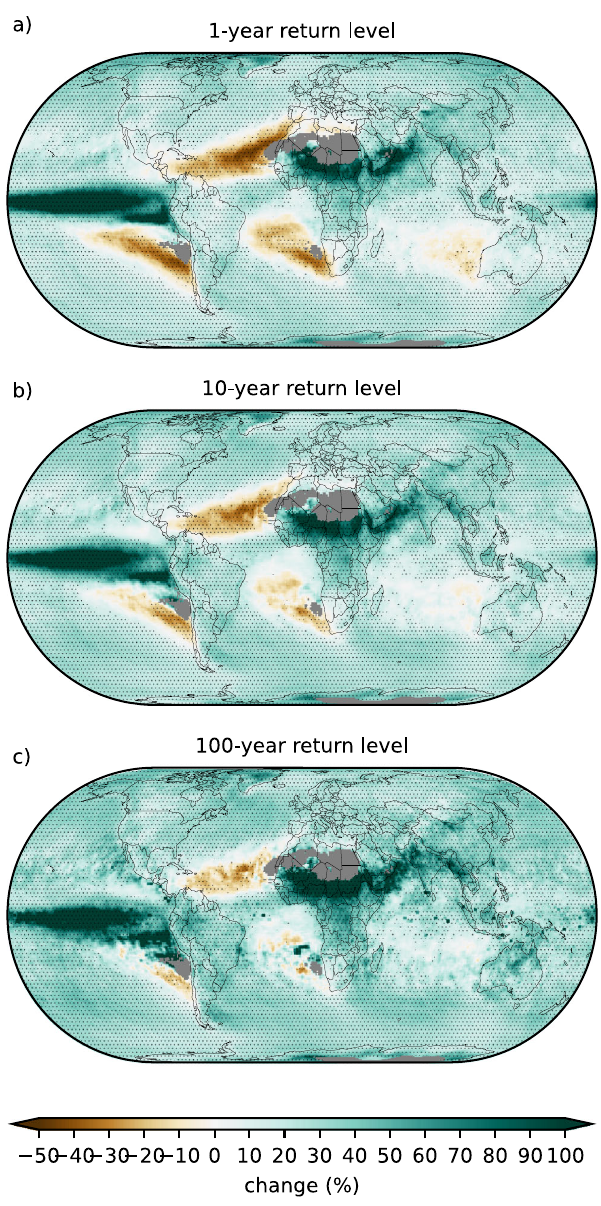
Fig. 2 Relative change of future vs historical precipitation return levels. Relative change of the a 1, b 10 and c 100-year return levels of daily precipitation expressed as weighted mean across 25 CMIP6 models for the SSP5-8.5 future period (2071-2100) with respect to the historical period (1971 – 2000) (Eq. (2)). Hatching is in the locations where >75% of the weighted models agree on the sign of the change. Dry areas (weighted mean of less than 3 events per year) are masked in